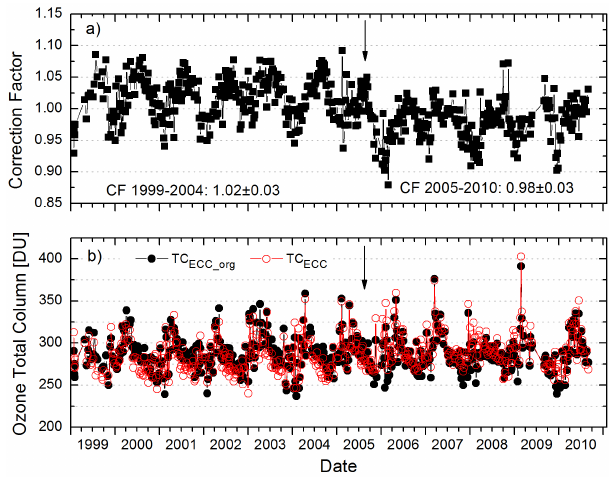
Fig. 7. Time series of correction factor (CF, according to Eq. 1) at the Iza˜na Observatory (a) and of ozone total col- umn amounts from ECC sondes without and with correction (TC ECC = CF · TC ECC org ) (b) . The mean correction factors for the periods 1999–2004 and 2005–2010 are also shown. The black ar- rows indicate the change-point date.